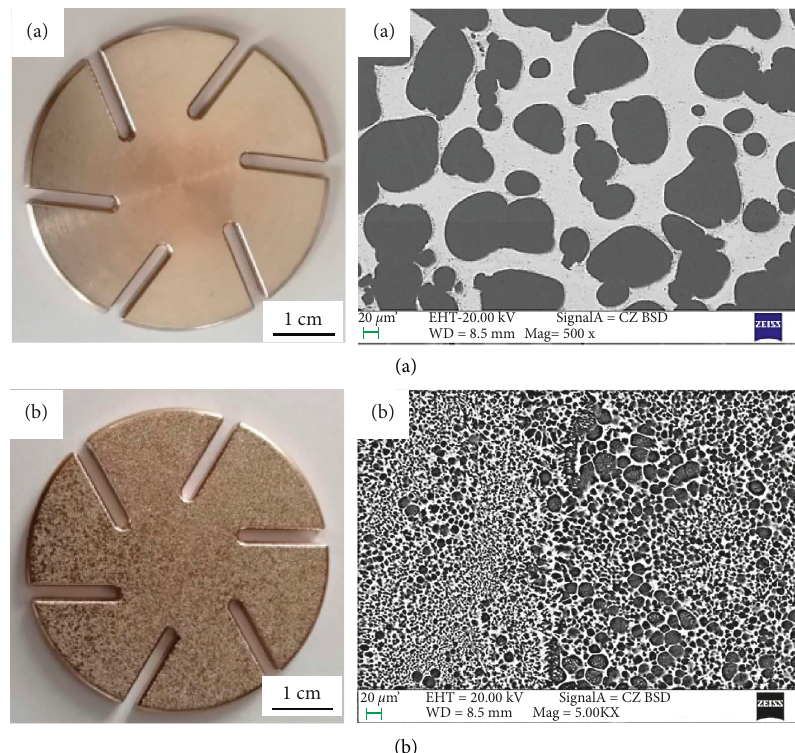
Figure 17: (a) Untreated. (b) LSM-treated Cu-50Cr contacts